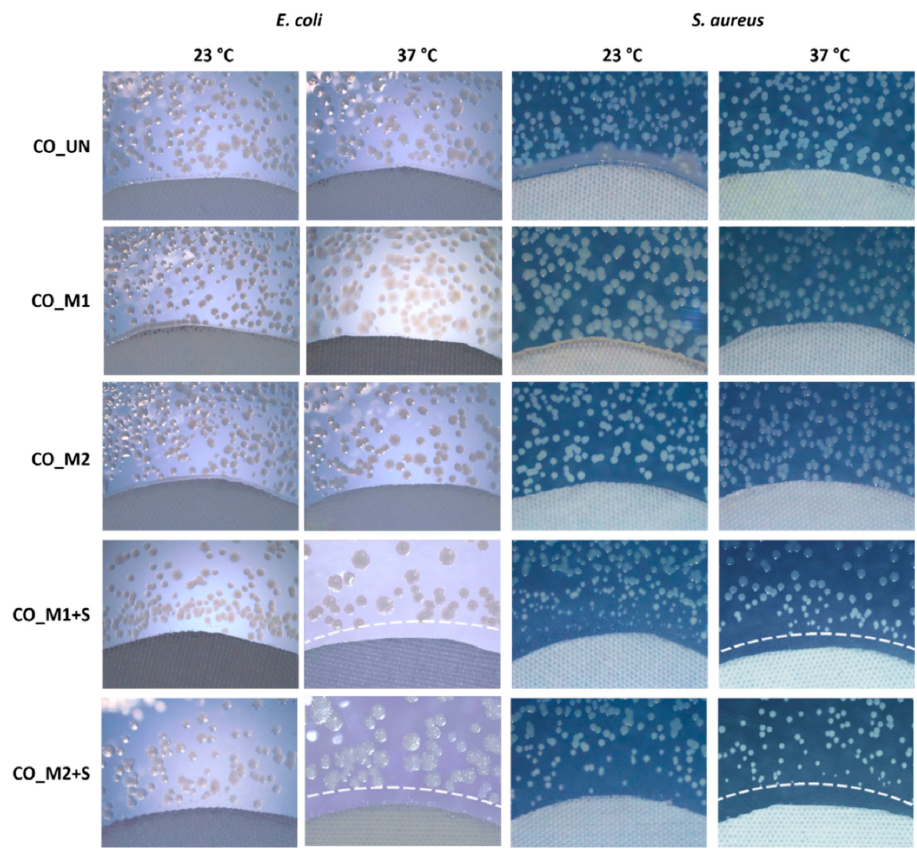
Figure 10. Zone of inhibition formed by the studied cotton-cellulose samples against gram-negative bacteria Escherichia coli and gram-positive bacteria Staphylococcus aureus , after the incubation at 23 or 37 °C.